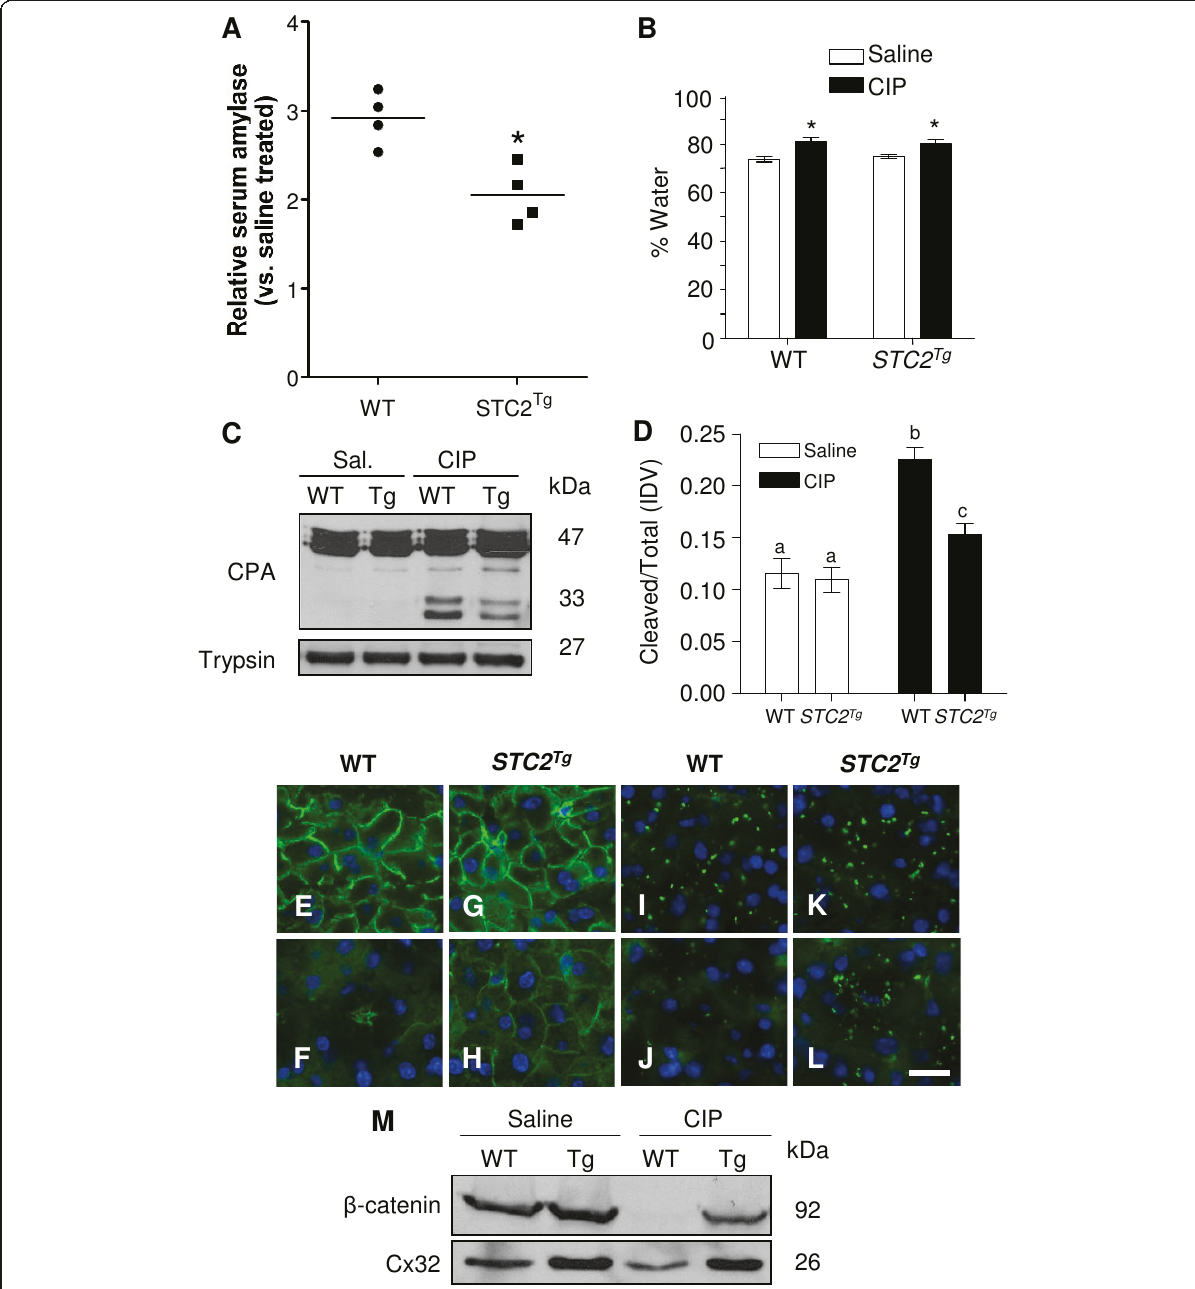
Figure 5 STC2 over-expression reduces severity of acinar cell damage during cerulein-induced pancreatic injury . (A) Analysis of serum amylase levels four hours into CIP treatment show that serum amylase levels rise approximately 3 fold in WT mice when compared to saline ( (cid:129) ) whereas the increase in STC2 Tg mice is significantly lower at 2-fold ( ■ ; * p < 0.01). (B) Tissue edema analysis revealed significant increases for both WT and STC2 Tg tissue 4 hours into CIP (black bars) when compared to saline controls (white bars; n = 4 animals). No difference between genotypes was observed. (C) Representative Western blot for procarboxypeptidase (47 kDa) and carboxypeptidase (CPA; 33 kDa) or trypsinogen four hours after initial saline (Sal.) or cerulein (CIP) injections showed decreased accumulation of activate CPA in STC2 Tg mice four hours into CIP. Trypsinogen levels do not differ between genotypes. (D) Quantification by densitometry (graph) comparing the ratio of cleaved (active; 33 kDa) to total CPA revealed a significant increase in WT tissue and, to a significantly lower extent, in STC2 Tg tissue (n = 4 animals, letters represent statistically different values; p < 0.05). IF analysis for b -catenin (E-H) or Cx32 (I-L) in wild type (WT) or STC2 Tg (Tg) mice four hours after initial injection of saline ( E, G, I, K ) or cerulein ( F, H, J, L ) showing decreased accumulation only in WT tissue during CIP. (M) Representative Western blot analysis on pancreatic protein extracts 4 hours after initial saline or cerulein (CIP) injection confirm decreased b -catenin and Cx32 accumulation only in WT-CIP treated tissue (n =